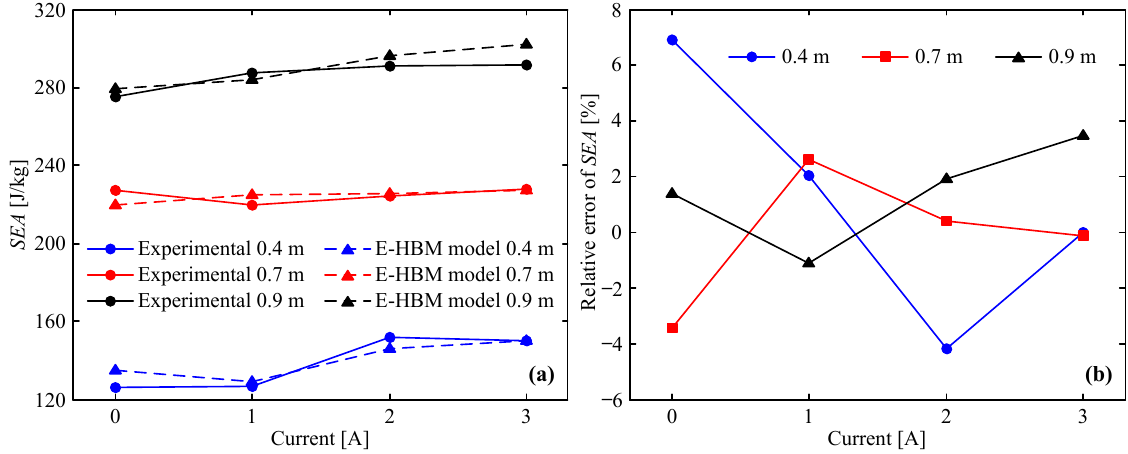
Figure 11. E–HBM model vs. measured data at different drop heights: ( a ) SEA , ( b ) relative error of SEA .